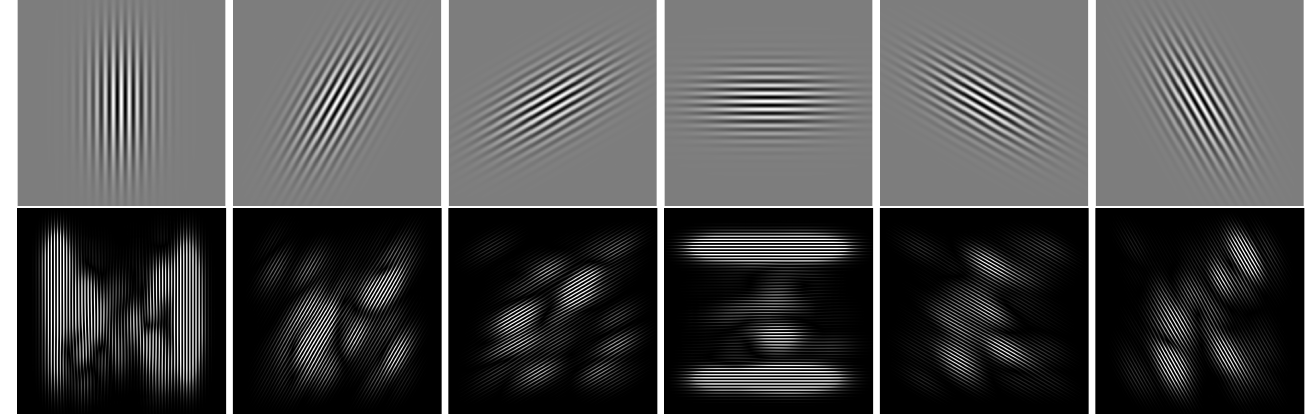
Figure 2. The Gabor feature images with different orientations. The first row shows the Gabor filters with 6 different orientations, and the second row shows the Gabor feature image corresponding to the first